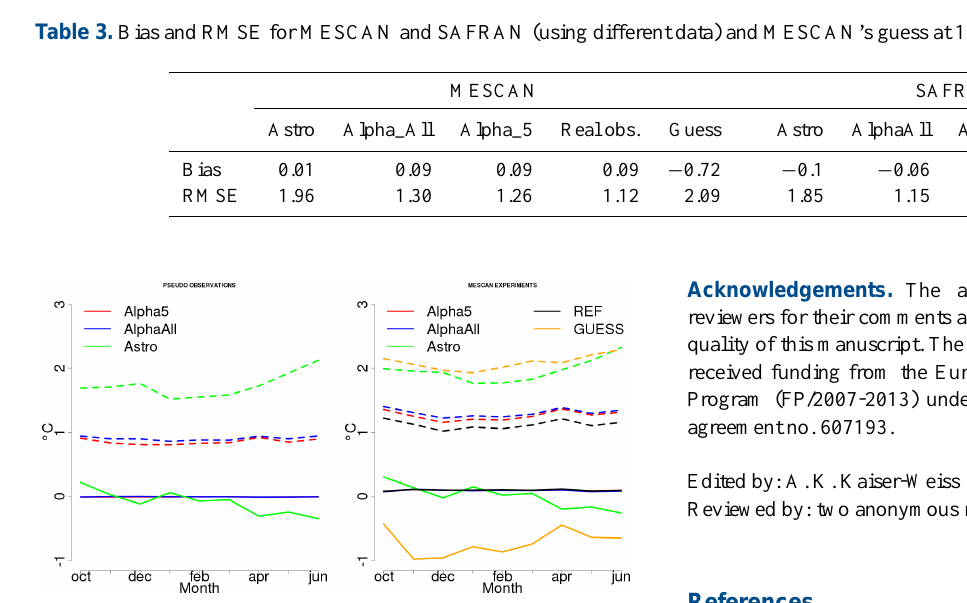
Figure 3. Bias (plain lines) and RMSE (dashed lines) for pseudo- observations (left) and MESCAN experiments (REF only uses real observations)